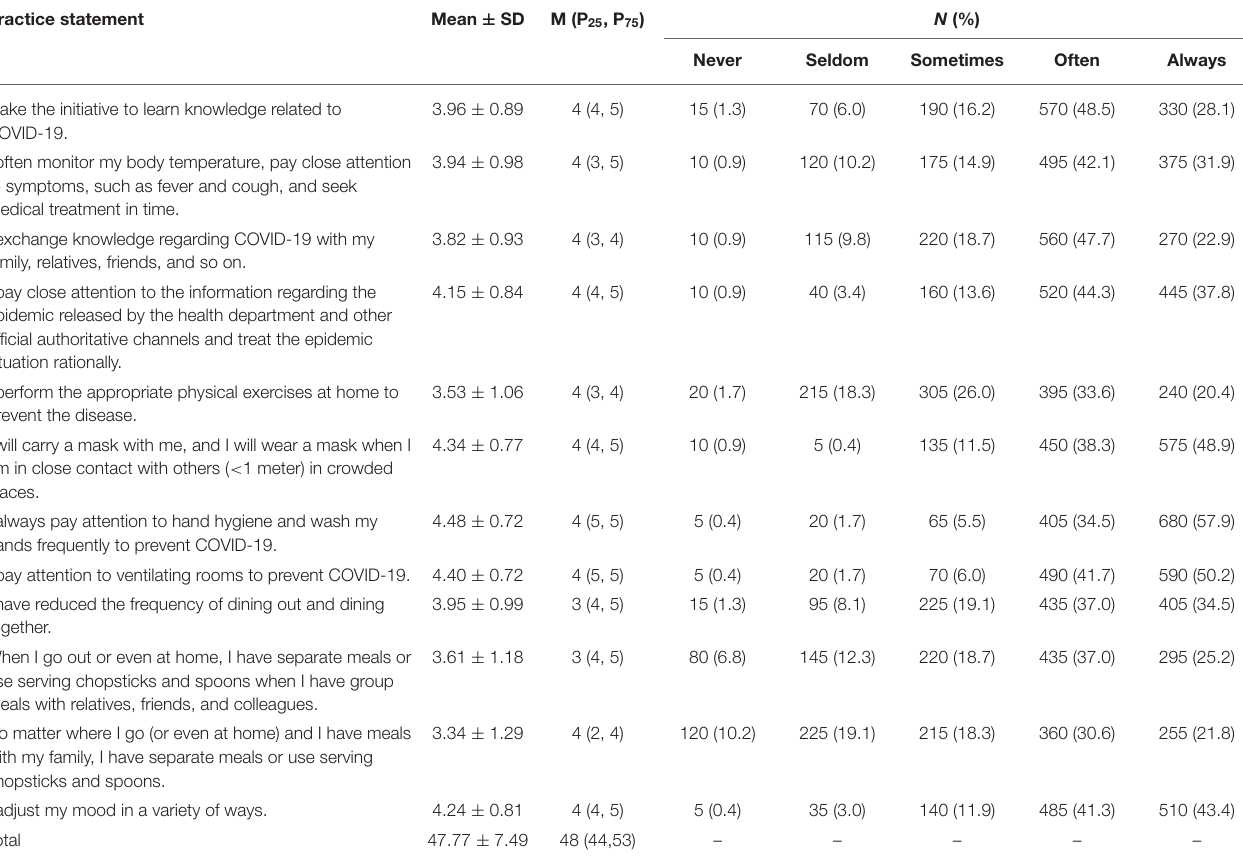
TABLE 4 | Practices of community residents against COVID-19 during the epidemic ( n = 1,175). Practice statement Mean ± SD M (P 25 , P 75 ) N (%)